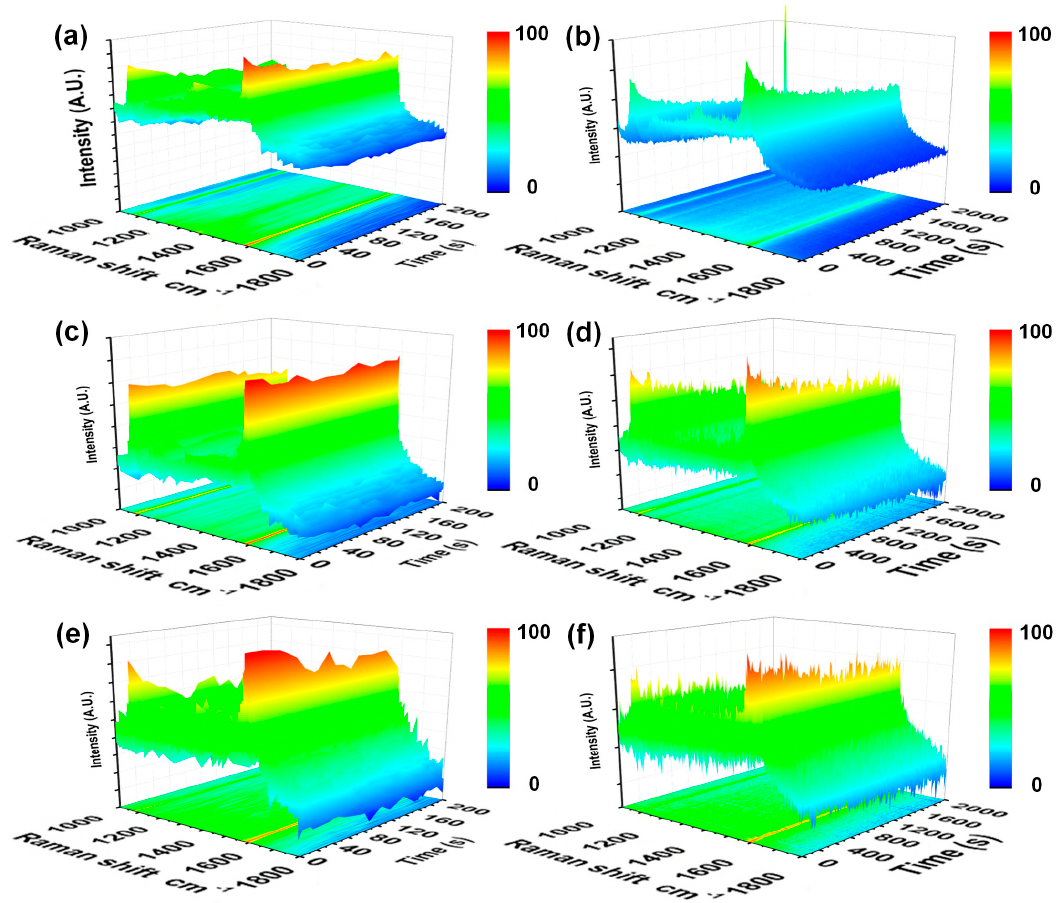
Figure 4. Time-dependent SERS spectra of Pt-based hollow nanostructures on Si, after adsorption of PATP from an ethanol solution, with different laser illumination time. The concentration of PATP in solution and laser irradiation time for collecting Raman spectra from these samples are: ( a ) 10 − 5 M, 200 s; ( b ) 10 − 5 M, 2000 s; ( c ) 10 − 6 M, 200 s; ( d ) 10 − 6 M, 2000 s; ( e ) 10 − 7 M, 200 s; ( f ) 10 − 7 M, 2000 s.